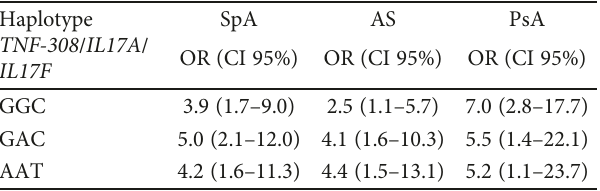
Table 6: Distribution of TNF-308/IL17A/IL17F haplotypes in individuals with SpA, AS, and PsA (interaction analysis with gender covariate).